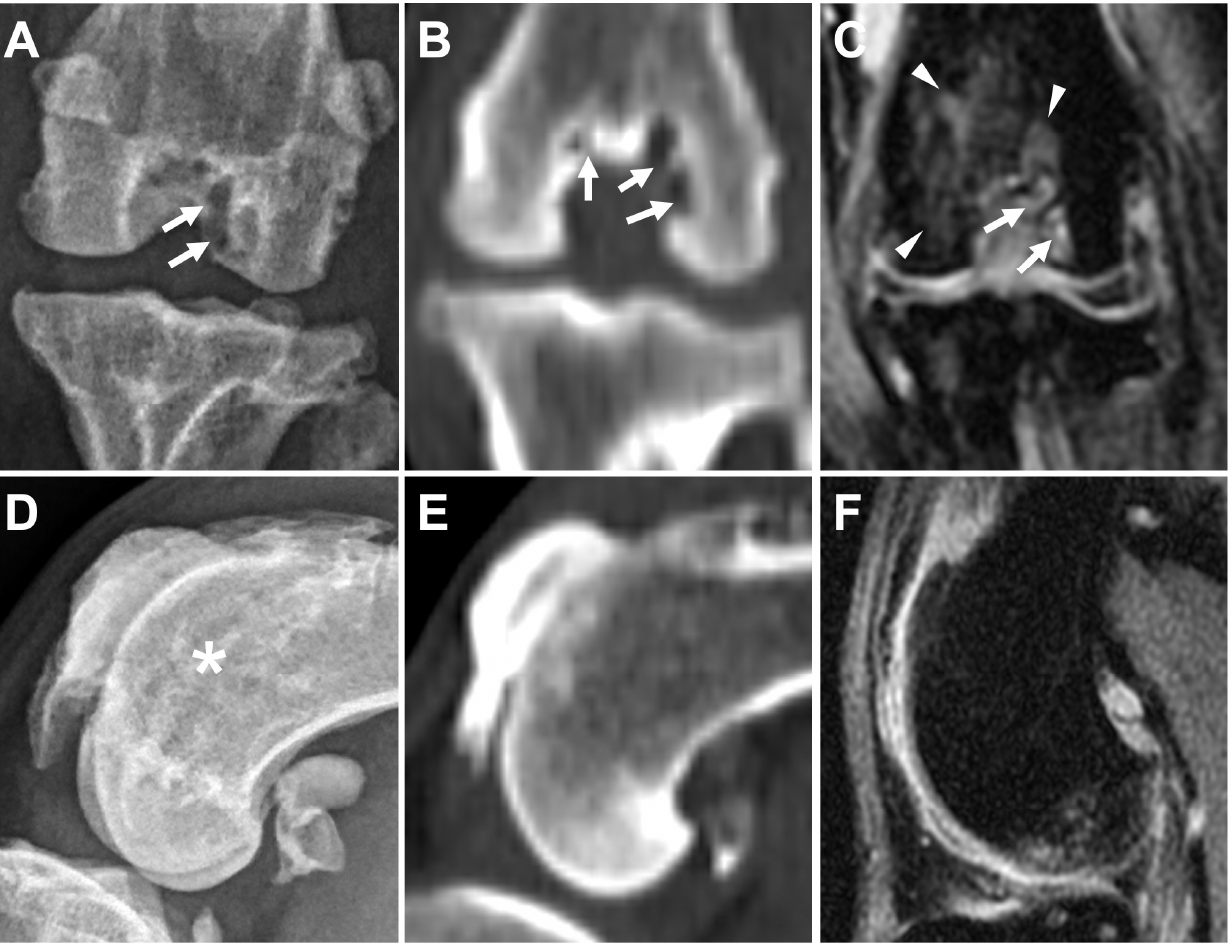
Figure 9. Comparison of subchondral bone defects, cysts, and bone-marrow-edema-like lesions of caudocranial view in caudocranial view on DR ( A ), bone window on CT (dorsal plane) ( B ), and PDW fs (dorsal plane) on MRI ( C ) in the same leg. Subchondral bone defects and cysts are mostly seen in two areas on DR ( A , arrow), in three areas on CT ( B , arrow), and in two areas on MRI ( A , arrow). Subchondral bone marrow edema-like lesions surrounding the intertrochlear fossa are only identified on MRI ( C, arrowheads). Subchondral bone defect-like lesion is suspected at the femoral trochlear region on DR image ( D , asterisk), but not identified on CT ( E ) nor MRI ( F ). Table 4. Comparison of the subchondral bone lesions on DR, CT, and MRI images at different ana- tomic subregions.